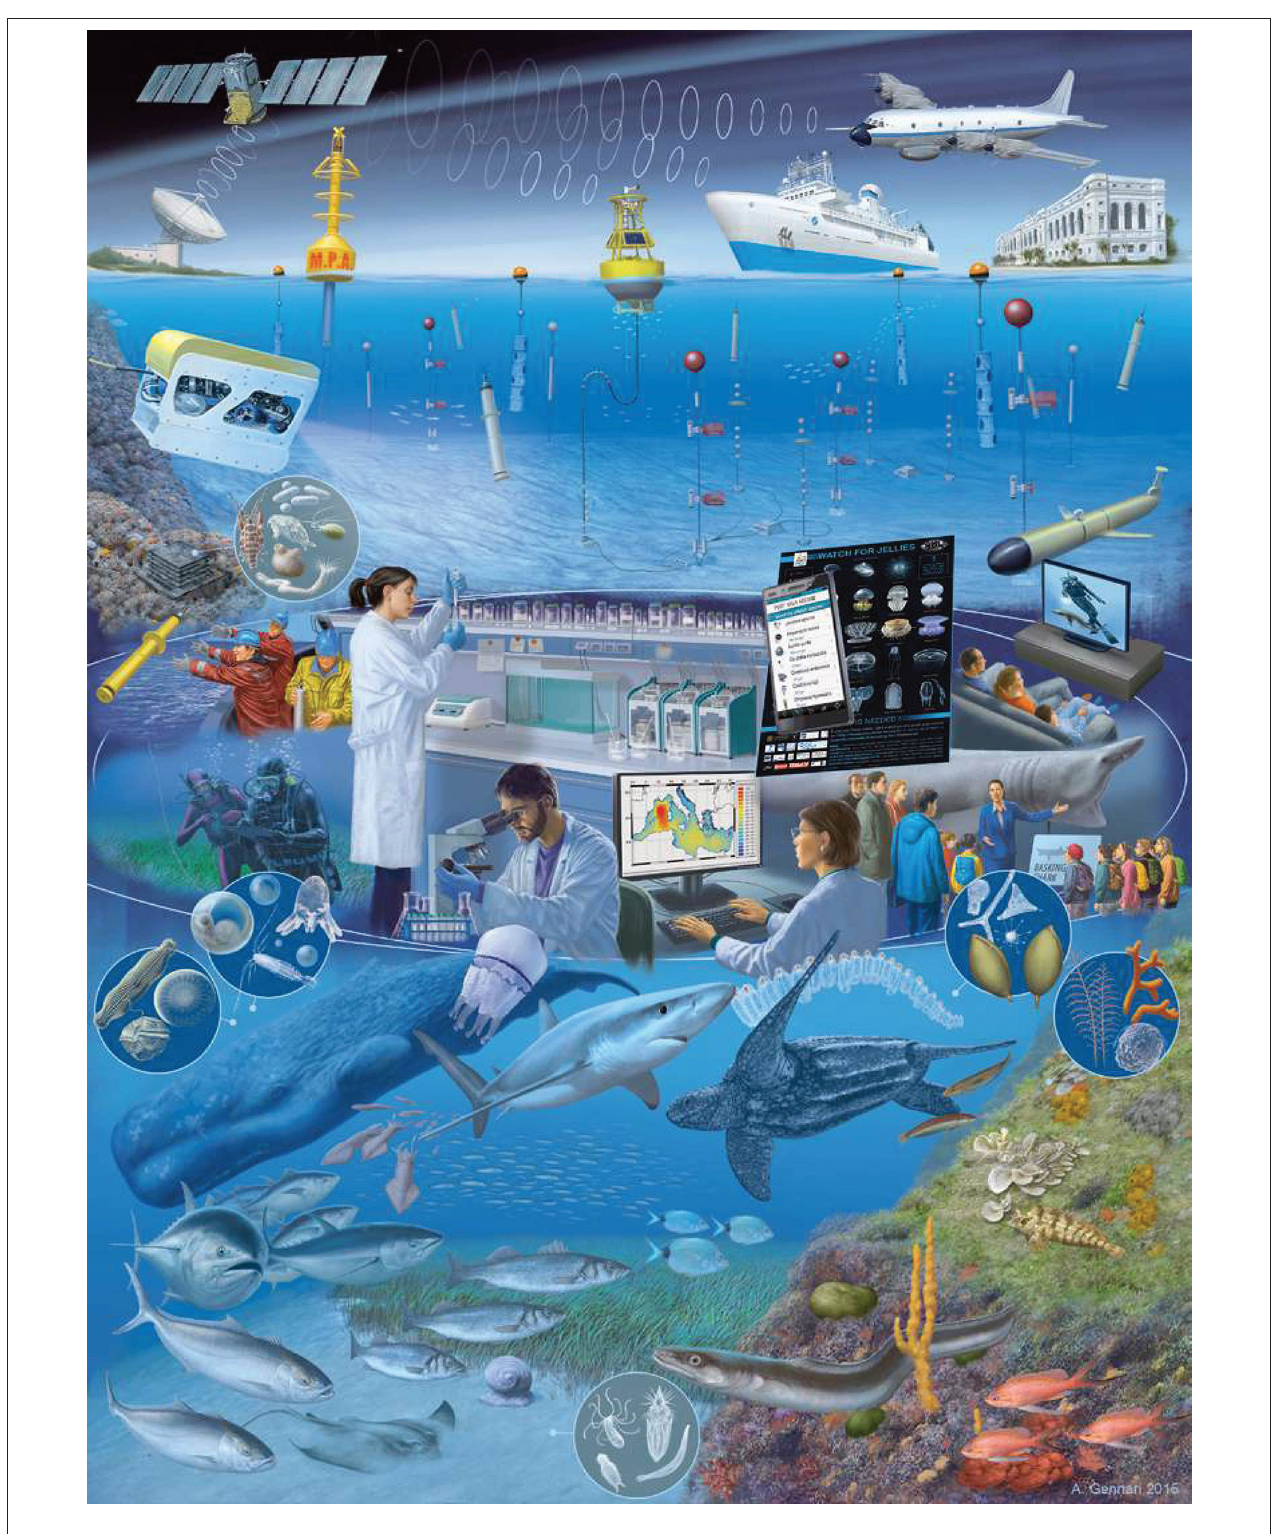
FIGURE 5 | December’s plate of the DEVOTES/CoCoNet calendar (Copyright: Alberto Gennari).